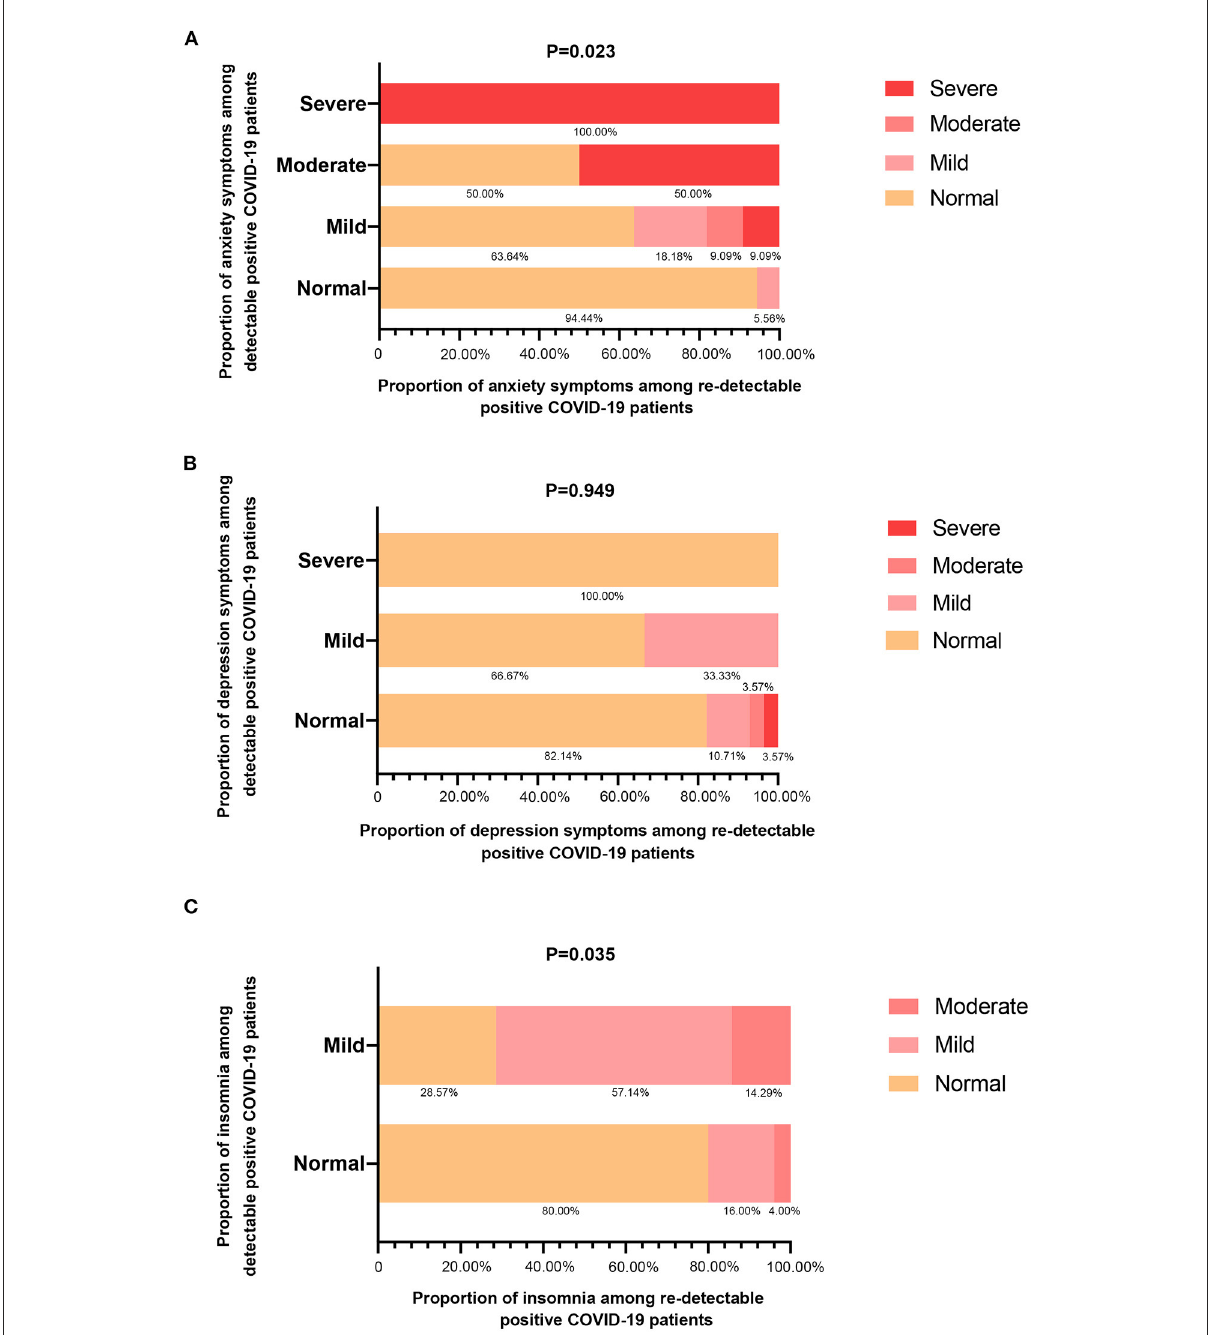
FIGURE1 Stacked bar charts illustrated the conversion of psychological status after re-detectable positive for COVID-19 patients following anxiety symptoms (A) , depression symptoms (B) , and insomnia (C) . Statistical comparison was obtained by the paired samples t -test for the alteration levels of all mental health